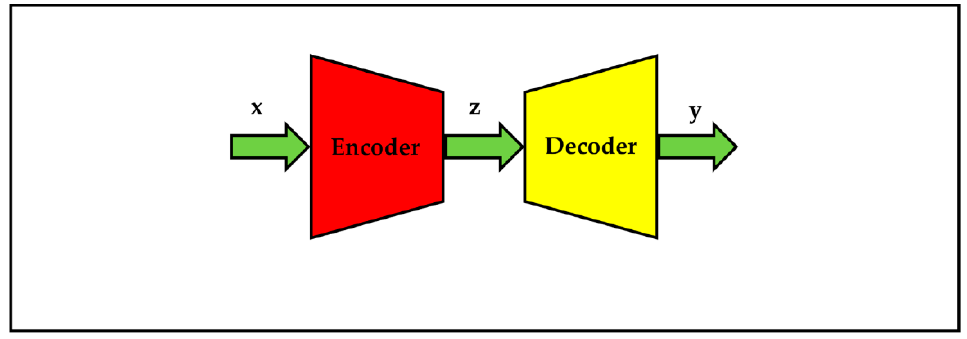
Figure 2. The architecture of classical auto-encoders.